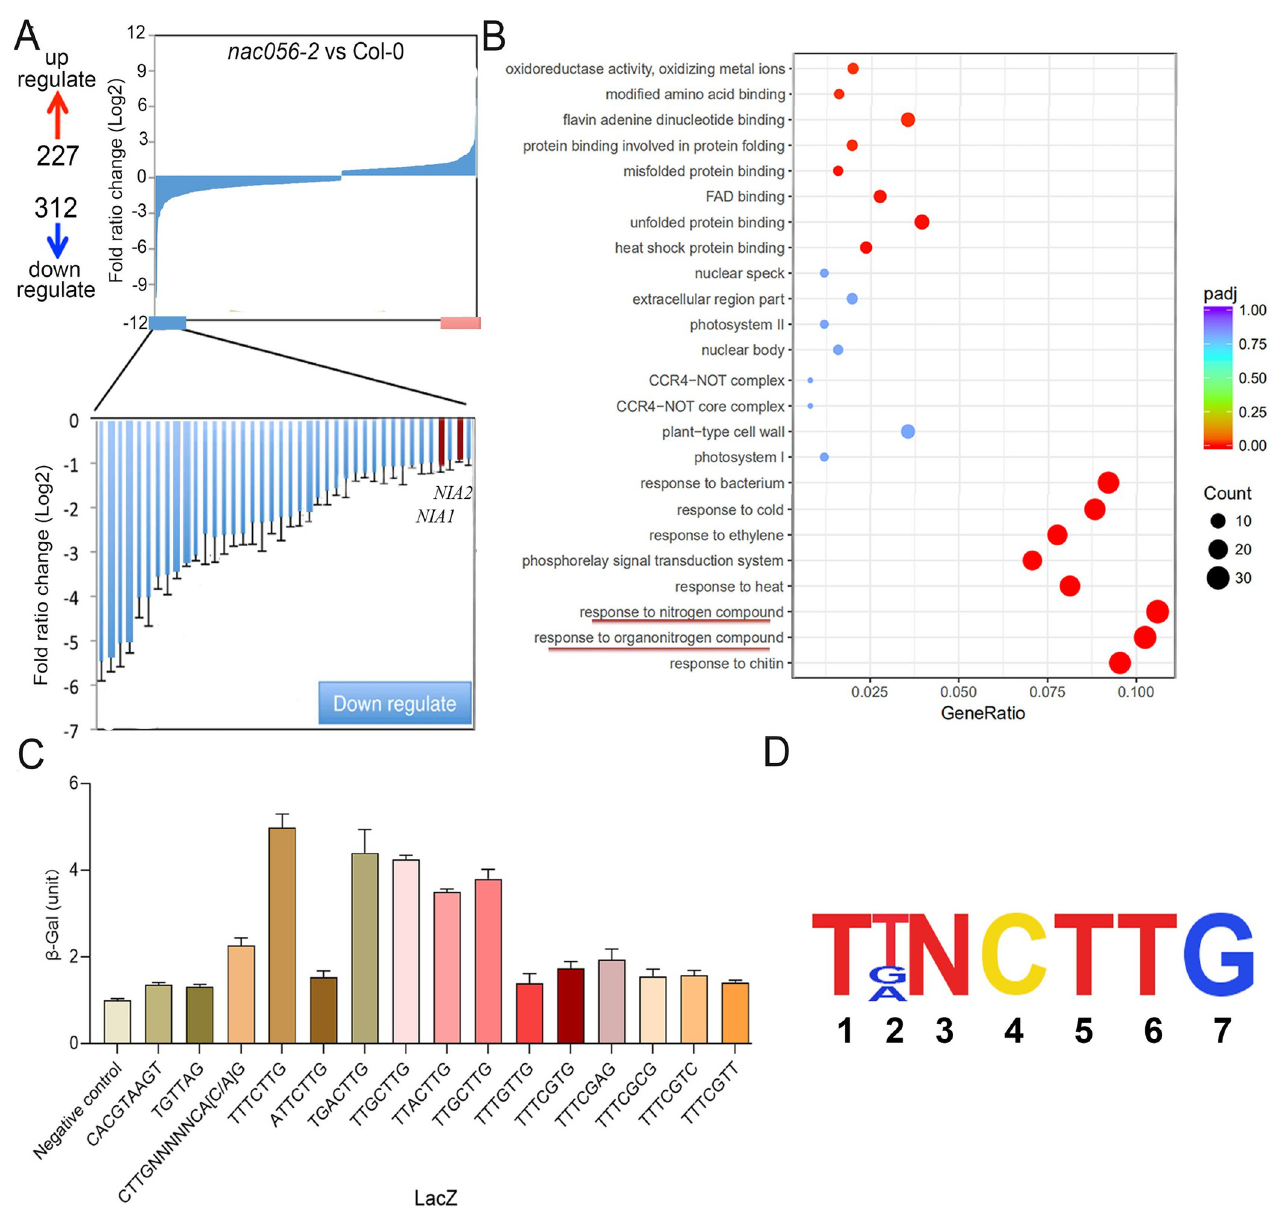
Fig 6. The differentially expressed genes in the nac056-2 mutant, and NAC056 binding-motif analysis. Relative expression levels of more than 500 genes that are induced or repressed by the nac056 mutation based on microarray analysis. B. GO (Gene Ontology) enrichment analysis of the top pathways in the down-regulated genes between Col-0 and the nac056-2 mutant. C. Interaction of NAC056 with the NAC056BM and its substituted sequences in yeast one- hybrid assays. The sequences of interest were fused to a promoter fragment of ACT2 (negative control) that does not contain a NAC056BM. β -Galactosidase ( β -Gal) activity (1 unit = 10 4 min -1 mL -1 ) was measured by liquid assays using chlorophenol red- β -D-galactopyranoside (CPRG; Roche Applied Science) according to the Yeast Protocol Handbook (Clontech). The yeast strain YM4271 was used in the assay. D. Figure indicates the core sequences of NAC056BM.